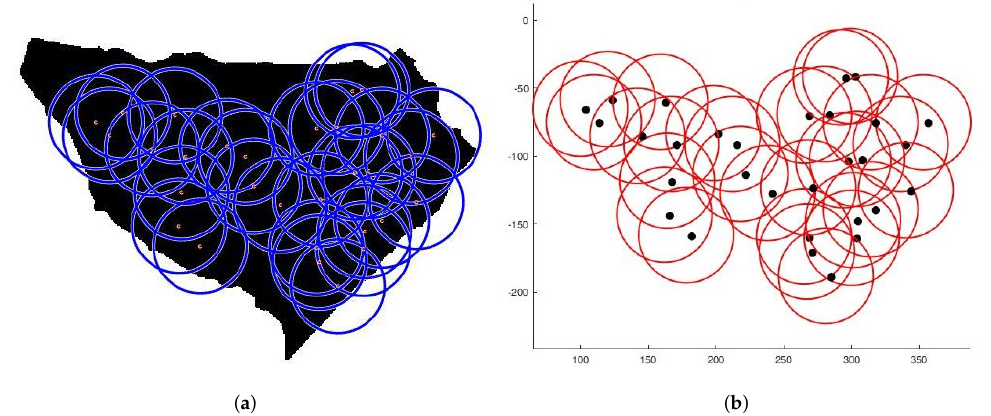
Figure 11. Deployment on second area. ( a ) Final positioning. ( b ) Connectivity scheme.